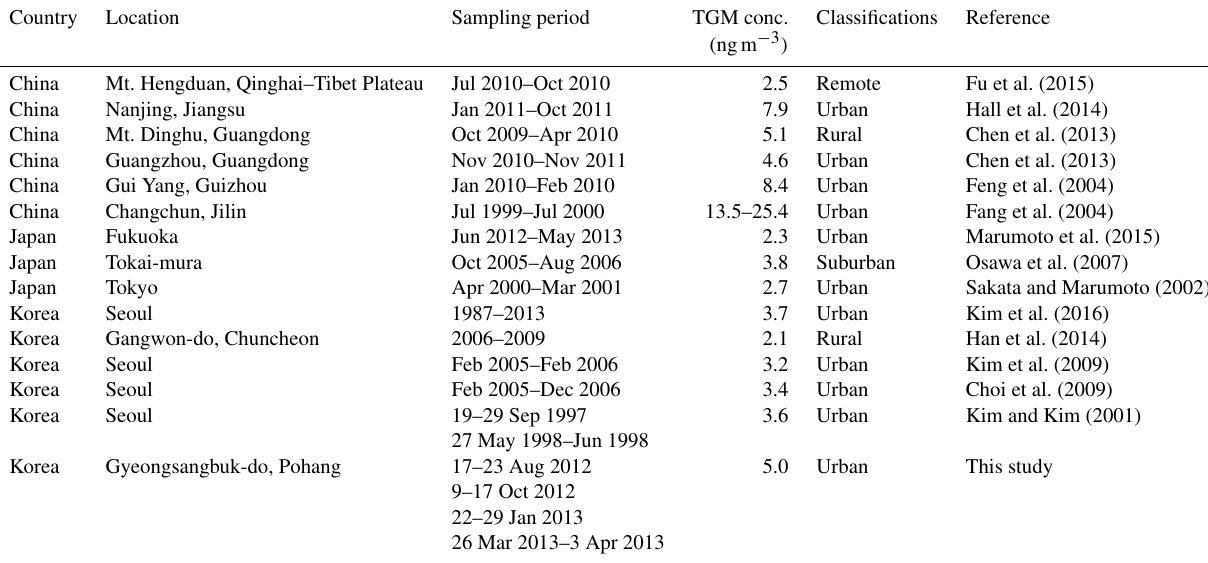
Table 1. Comparison with previous studies for TGM concentrations. Country Location Sampling period TGM conc.